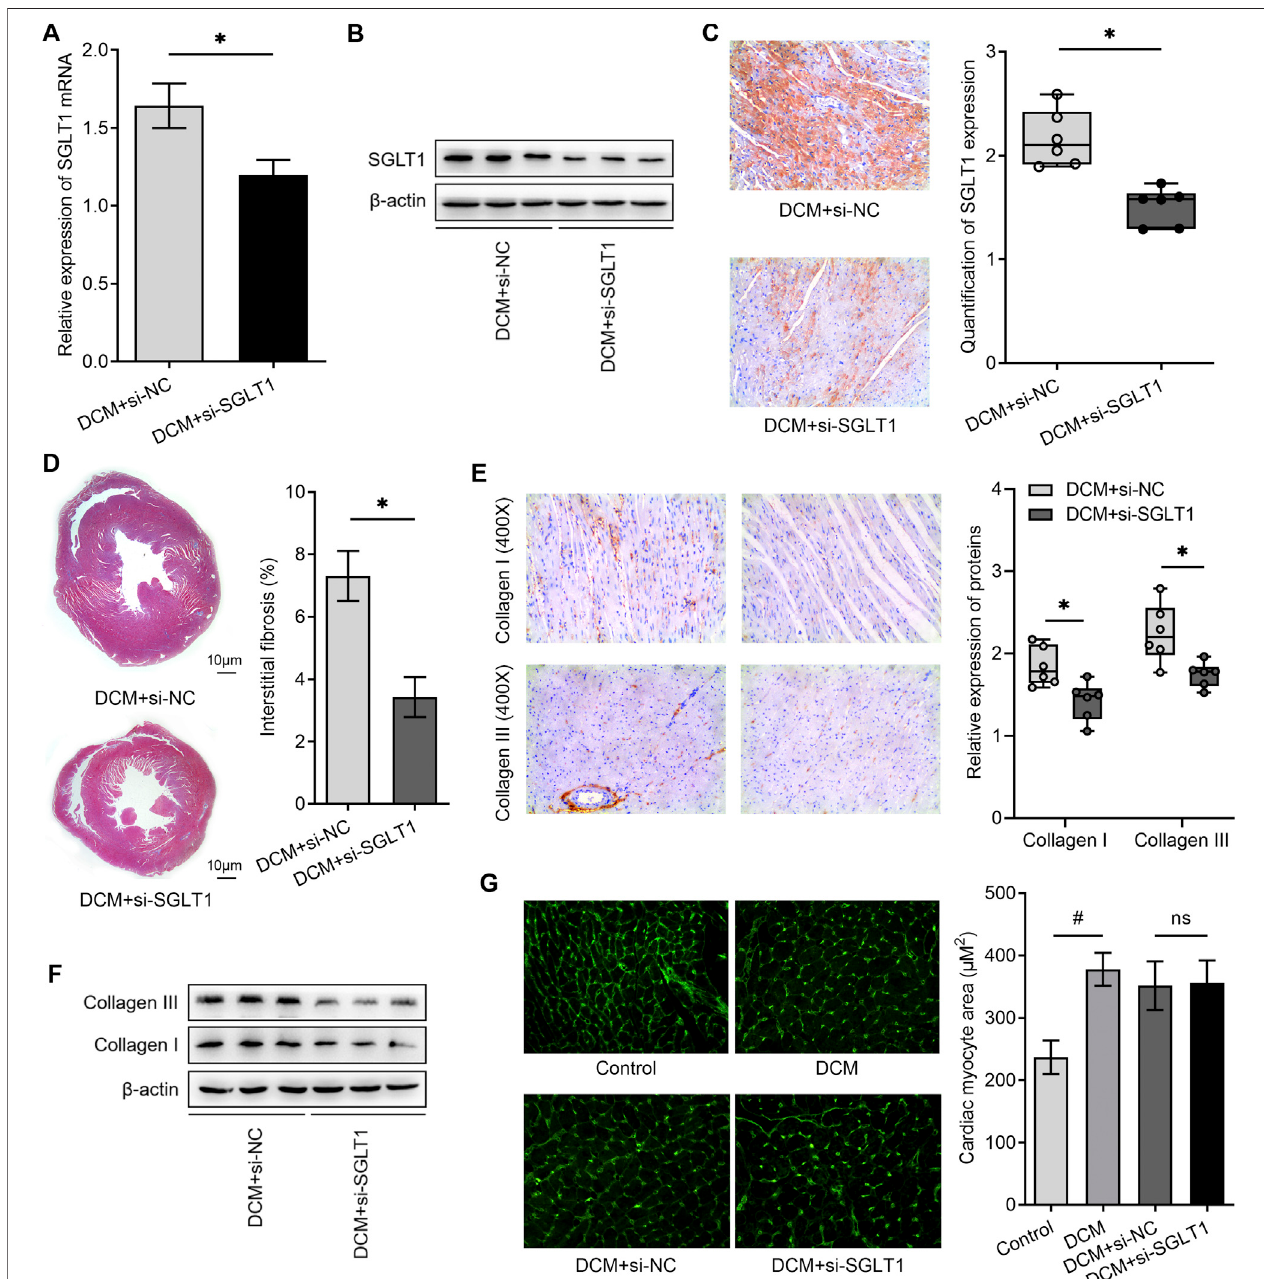
FIGURE 5 | SGLT1 inhibition alleviated myocardial fi brosis and apoptosis in diabetic rat hearts ( n (cid:2) 6). (A, B) Knockdown of SGLT1 was achieved by continuous intravenousinjection intothetailveinwithspeci fi cSGLT1 siRNAinDCM rats,and theknockdown ef fi ciencywasidenti fi ed bydetecting SGLT1expression inmyocardial tissues using RT-qPCR and western blotting analysis. (C) SGLT1 protein levels in myocardial tissue were measured by immunohistochemistry staining. (D) Masson ’ s trichrome stainingof myocardial tissue shows interstitial fi brosis in DCM rats treated withsi-NC or si-SGLT1. (E, F) Relative protein levels ofcollagen I and collagen III in myocardial tissue were measured using immunohistochemical staining and western blotting analysis ( n (cid:2) 6). (G) Wheat germ agglutinin staining and quantitation of myocardial cell size in DCM rats treated with si-NC or si-SGLT1 ( n (cid:2) 6).